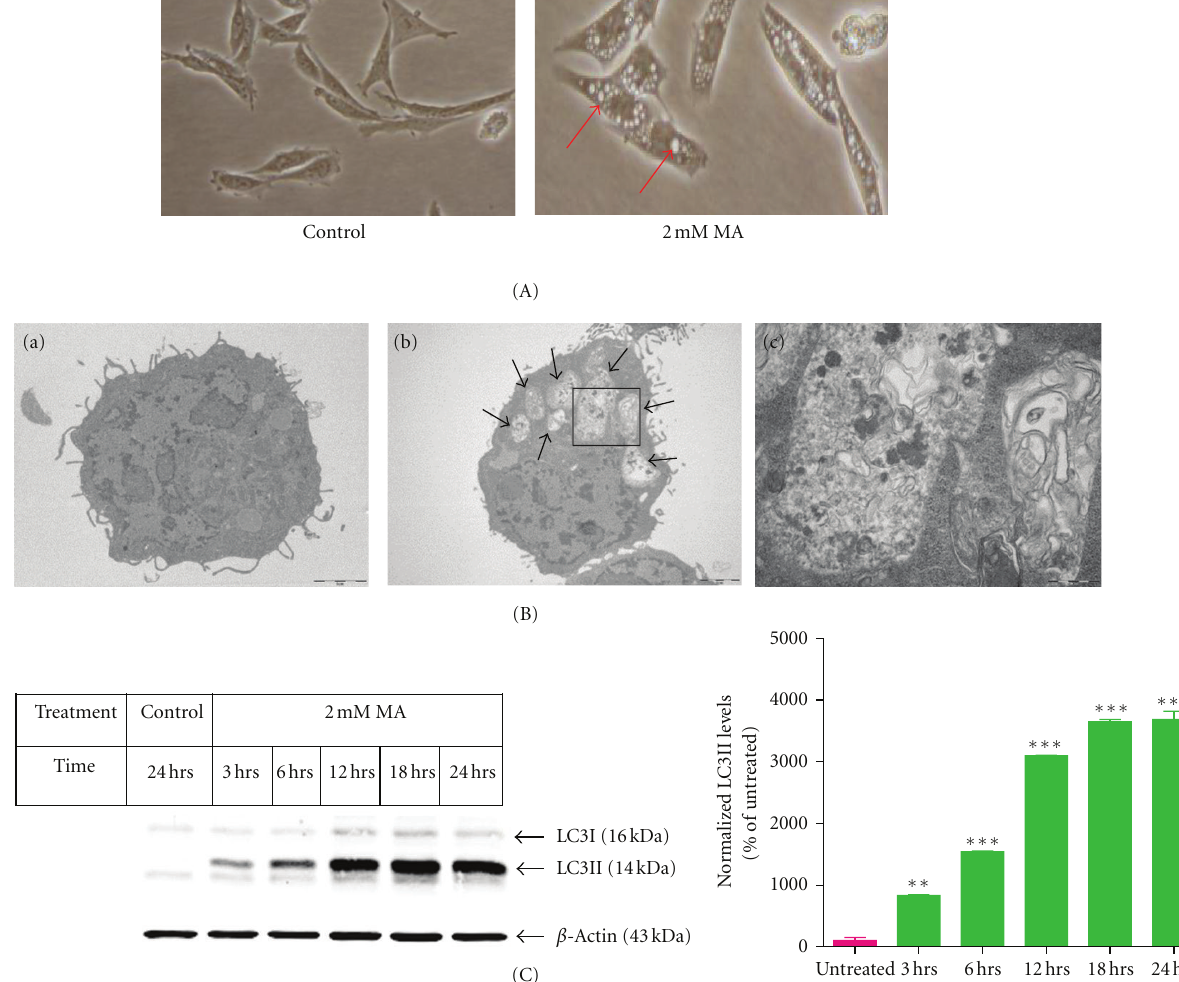
Figure 1: MA induces autophagy. (A) Representative phase contrast microscopy pictures showing abundant cytoplasmic vacuoles (arrows) in N27 dopaminergic cells treated with MA (2mM) for 12 hours. (B) Representative transmission electron microscopy image analysis of N27 dopaminergic cells exposed to MA (2mM) for 12 hours: (a) untreated N27 dopaminergic cells; (b) boxed area; (c) autophagosomes observed in N27 dopaminergic cells treated with MA (2mM) (arrows). Morphology of autophagosomes is characterized by the formation of double membrane vacuoles harboring damaged organelles (arrows) and insoluble protein aggregates. (C) Time-dependent increase in LC3-II levels. N27 dopaminergic cells were exposed to MA (2mM) for 3, 6, 12, 18, and 24 hours. Equal loading of protein in each lane is confirmed by probing the membrane with β -actin antibody. Densitometry analysis of LC3-II induction is represented next to the Western blot image. LC3-II bands were quantified and expressed as percentage of untreated control. Data represent mean ± SEM, n = 2. ∗∗ P < 0 . 01 and ∗∗∗ P < 0 . 001 compared with untreated